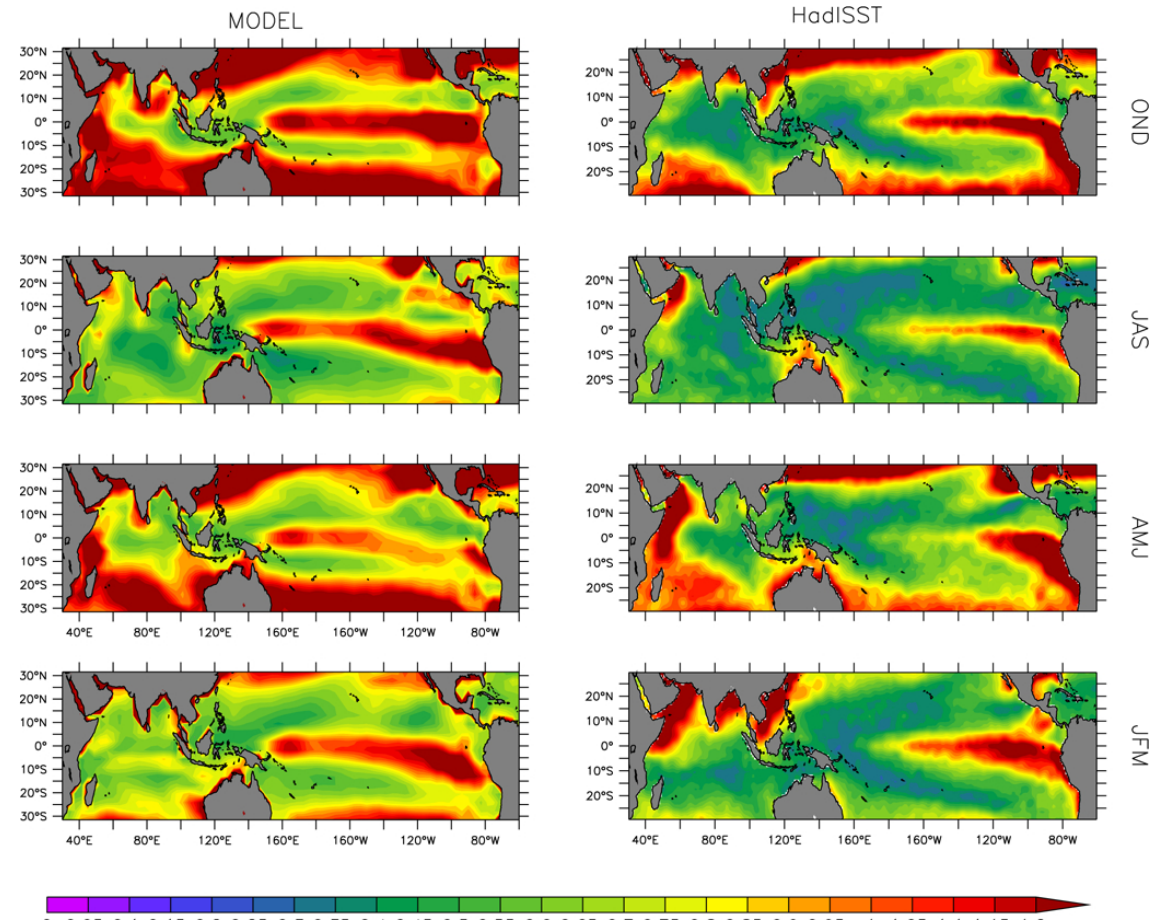
Fig. 8. Standard deviation of the seasonal mean inter-annual variability of the SST (in K). The left and right columns show results from the TRANS simulation, and from the HadISST data (Rayner et al., 2003), respectively, both for the year 1900–1999 (not